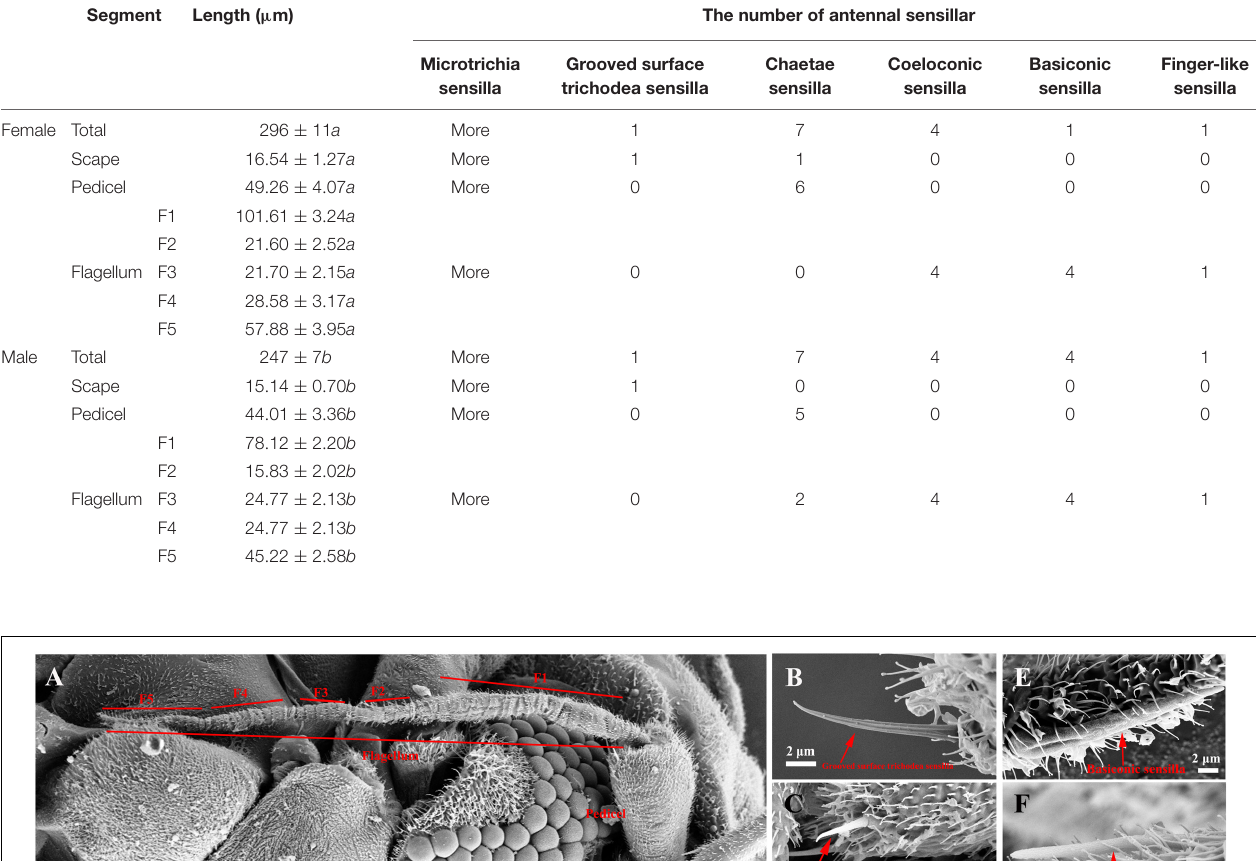
TABLE 1 | Antennal length and chemosensillar distribution on the antennae of A. spiniferus.